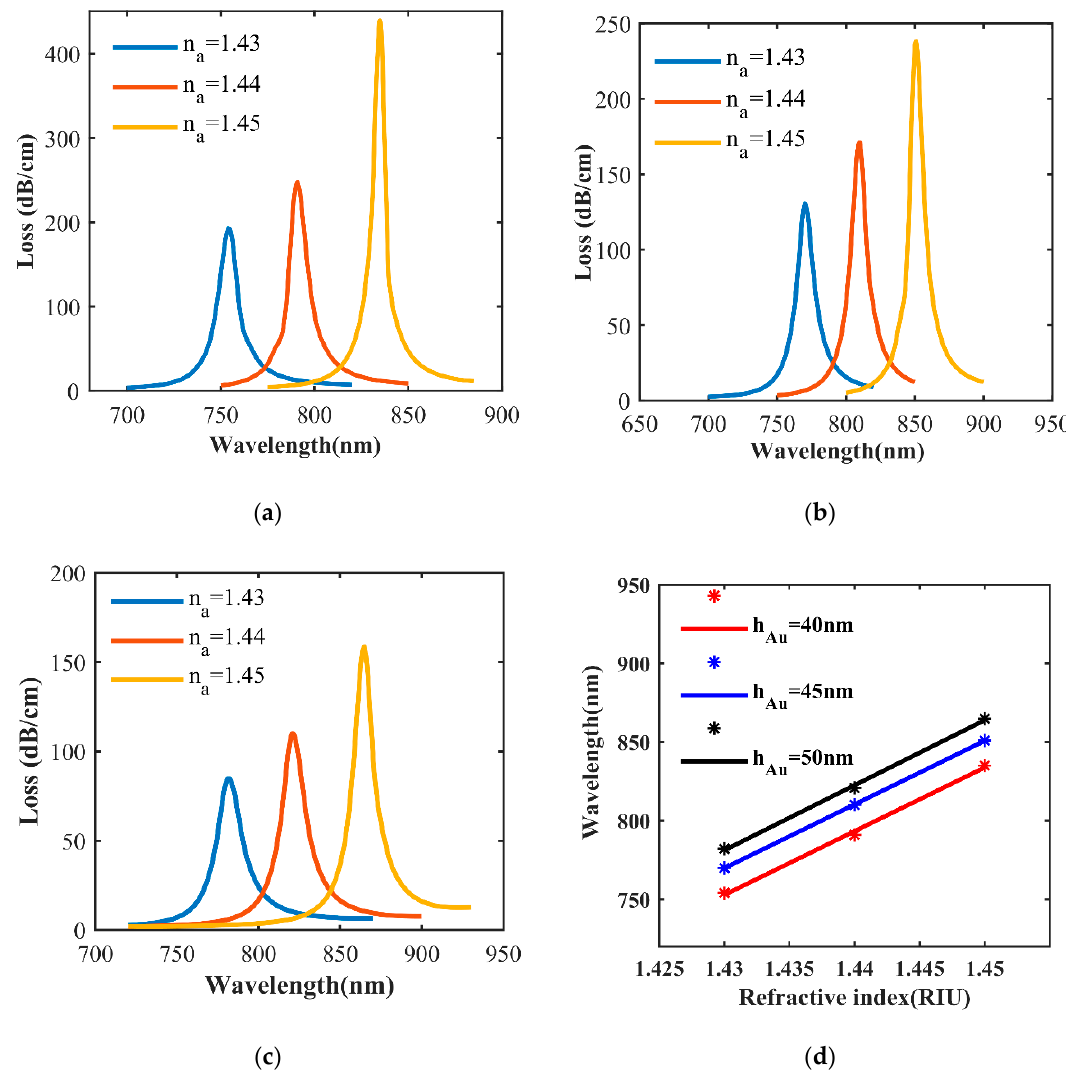
Figure 11. Influence of RI on the loss spectrum with different h Au from 40 nm to 50 nm. ( a ) h Au = 40 nm, ( b ) h Au = 45 nm, ( c ) h Au = 50 nm, and ( d ) the fitted results of resonant wavelength of y-polarized fiber core mode with different h Au , where the red, blue, and black markers are the simulation results. Table 2. Comparison of the refractive index sensitivity of the proposed PCF-SPR with different h Au from 40 nm to 50 nm.